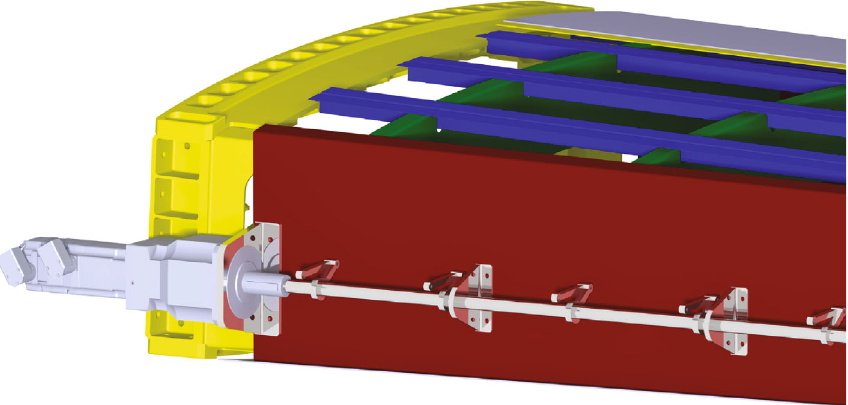
Figure 21: Connection of the actuation system to the front spar.